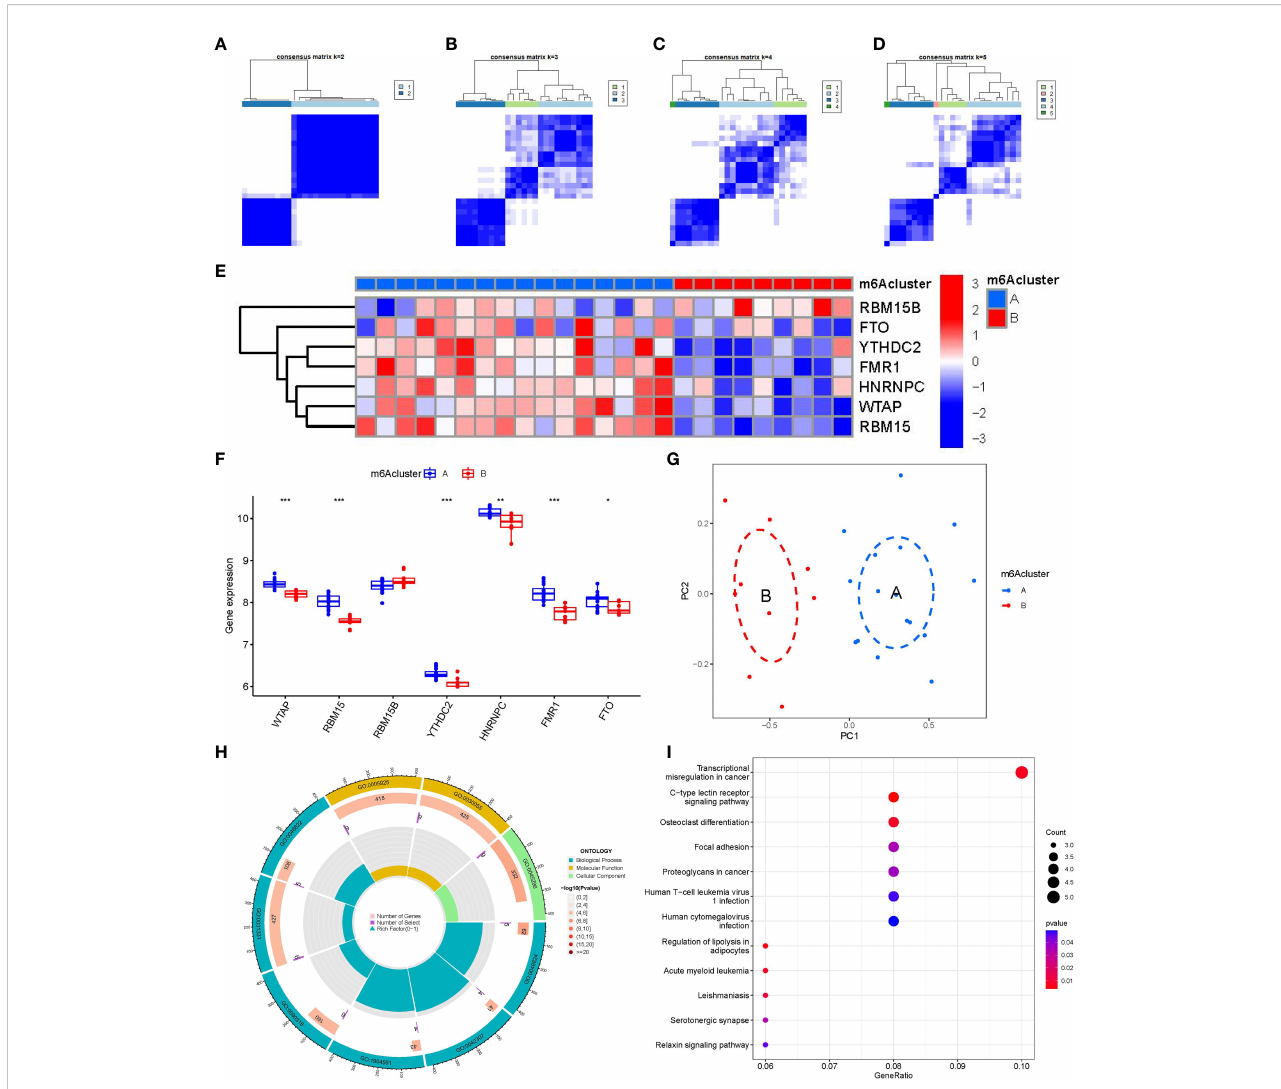
FIGURE 6 Consensus clustering of the 7 signi fi cant m6A modulators in PMOP. (A – D) Consensus matrices of the 7 signi fi cant m6A modulators for k = 2 – 5. (E) Expression heat map of the 7 signi fi cant m6A modulators in clusterA and clusterB. (F) Differential expression boxplots of the 7 signi fi cant m6A modulators in clusterA and clusterB. (G) Principal component analysis for the expression pro fi les of the 7 signi fi cant m6Amodulators that shows a remarkable difference in transcriptomes between the two m6A patterns. (H, I) GO and KEGG analysis that explores the potential mechanism underlying the effect of the 90 m6A-related DEGs on the occurrence and development of PMOP. *p < 0.05, **p < 0.01, and ***p <